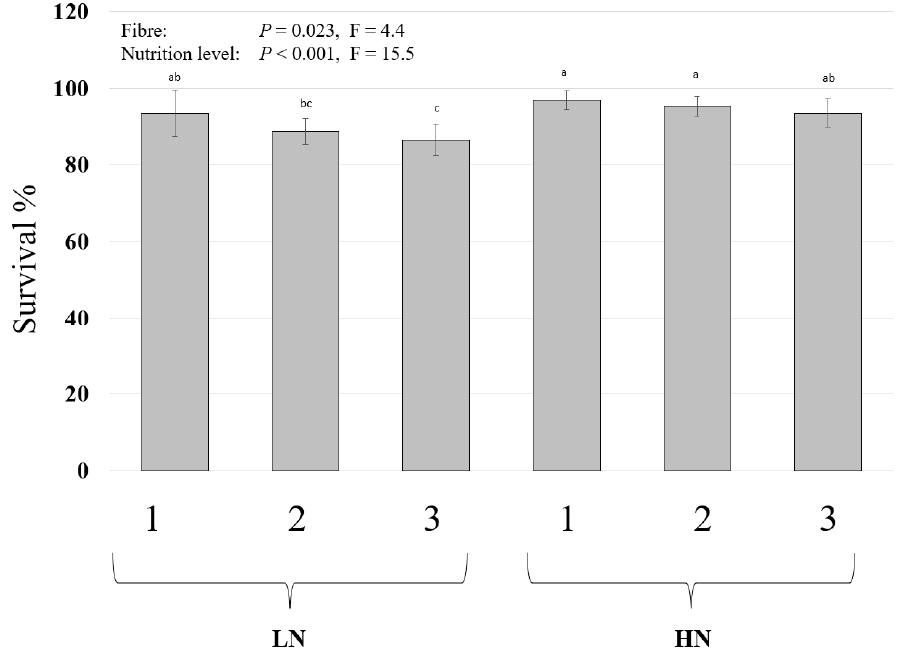
Figure 3. The survival of black soldier fly (BSF) larvae grown on different fibre components and two nutrient levels. BSFL were grown in high-nutrient (HN) or low-nutrient (LN) substrates and with 3 fibre components (1: powder cellulose, 2: lignocellulose, or 3: ground straw). The larvae were harvested, and the survival was assessed. Two-way ANOVA (n = 5, p < 0.05) followed by Bonferroni post hoc test revealed that both factors influenced the survival of the larvae without an interaction between the factors. Significant differences are found between treatments 1 and 3 (main effect), and pairwise differences are indicated by different letters above the